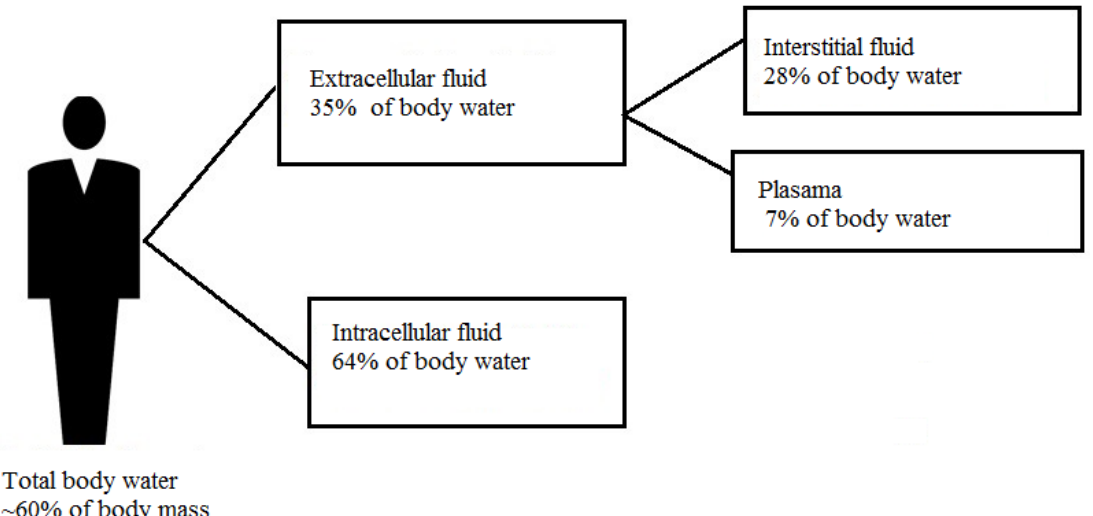
Figure 1. Distribution of water in compartmentalised tissue space of a 70 kg adult